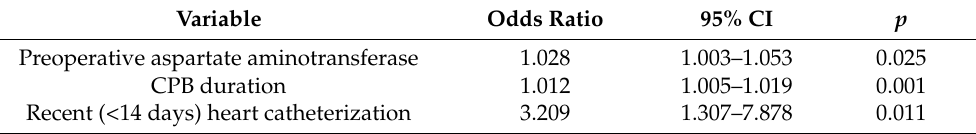
Table 4. Multivariable analysis of factors associated with postoperative acute kidney injury.